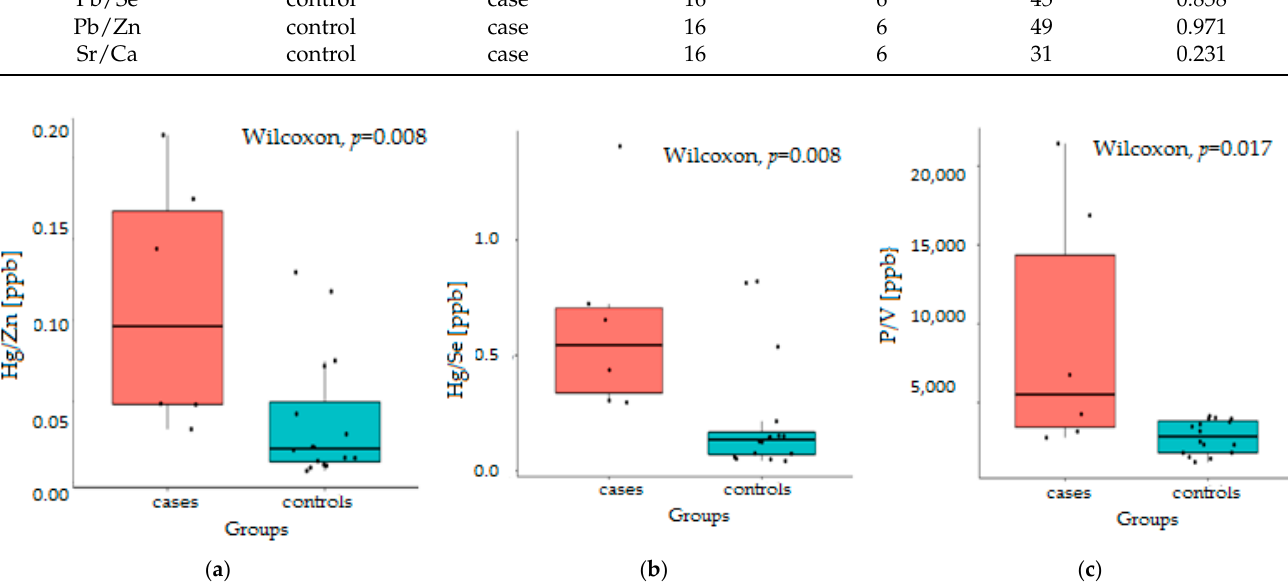
Figure 3. Differences in the Hg/Zn ( a ), Hg/Se ( b ), and P/V ( c ) ratios in AH of HD patients compared to the control. Table 3. Differences between the control (group I, n = 16) and HD patients (group 2, n = 6) consid- ering the selected elemental ratios. Statistically significant correlations are marked in red.